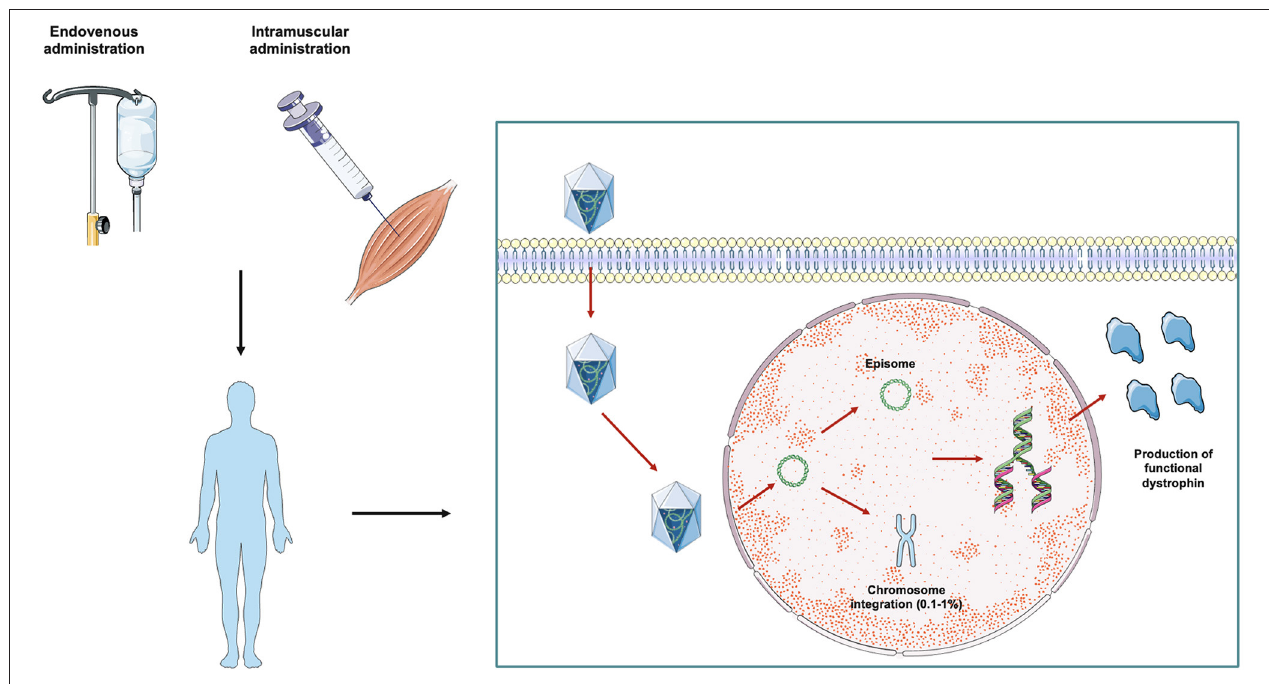
FIGURE 1 | AAV-mediated gene therapy in DMD from bench to bedside. Gene therapy approaches in DMD currently under study are based on the delivery of reduced-length mini- or micro-dystrophin protein packaged within an adeno-associated virus (AAV). The therapeutic vector can be administered systemically via the intravenous route or directly within the involved muscles. After the injection, AAV vectors are imported inside the cell by internalization in clathrin coated endocytic vesicles. The vectors are then released from the vesicles into the cytoplasm and translocated to the nucleus where transgenes are released. Once inside the nucleus, the exogenous DNA particle remains in transduced cells in episomal state, and only a very small percentage (0.1–1%) of the vector genome is integrated into the host chromosome. Transduced cells then start expressing the transgene, with consequent production of a truncated, but functional, dystrophin